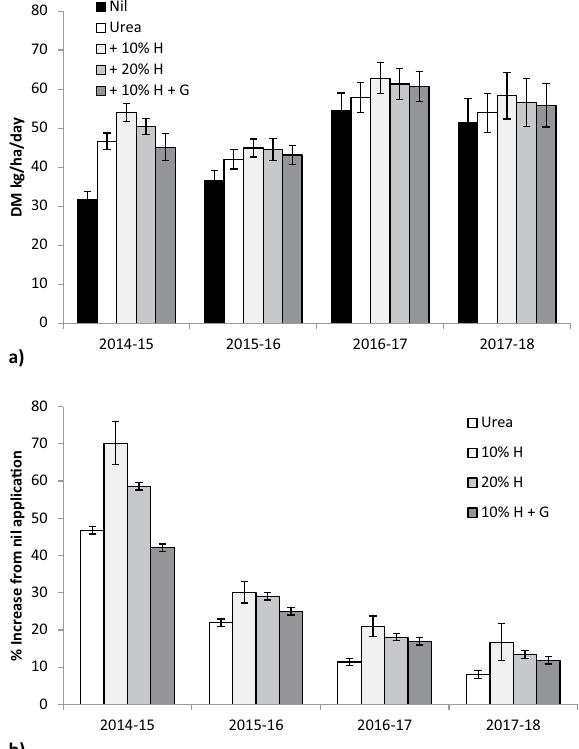
Figure 1. ( a ) Effect of urea, humate (H) and guano (G) addition to urea on pasture dry matter (DM) production 2014–15, 2015–16, 2016–17, 2017–18 growing seasons; ( b ) Change in production relative to unfertilised grassland, mean ± standard error.